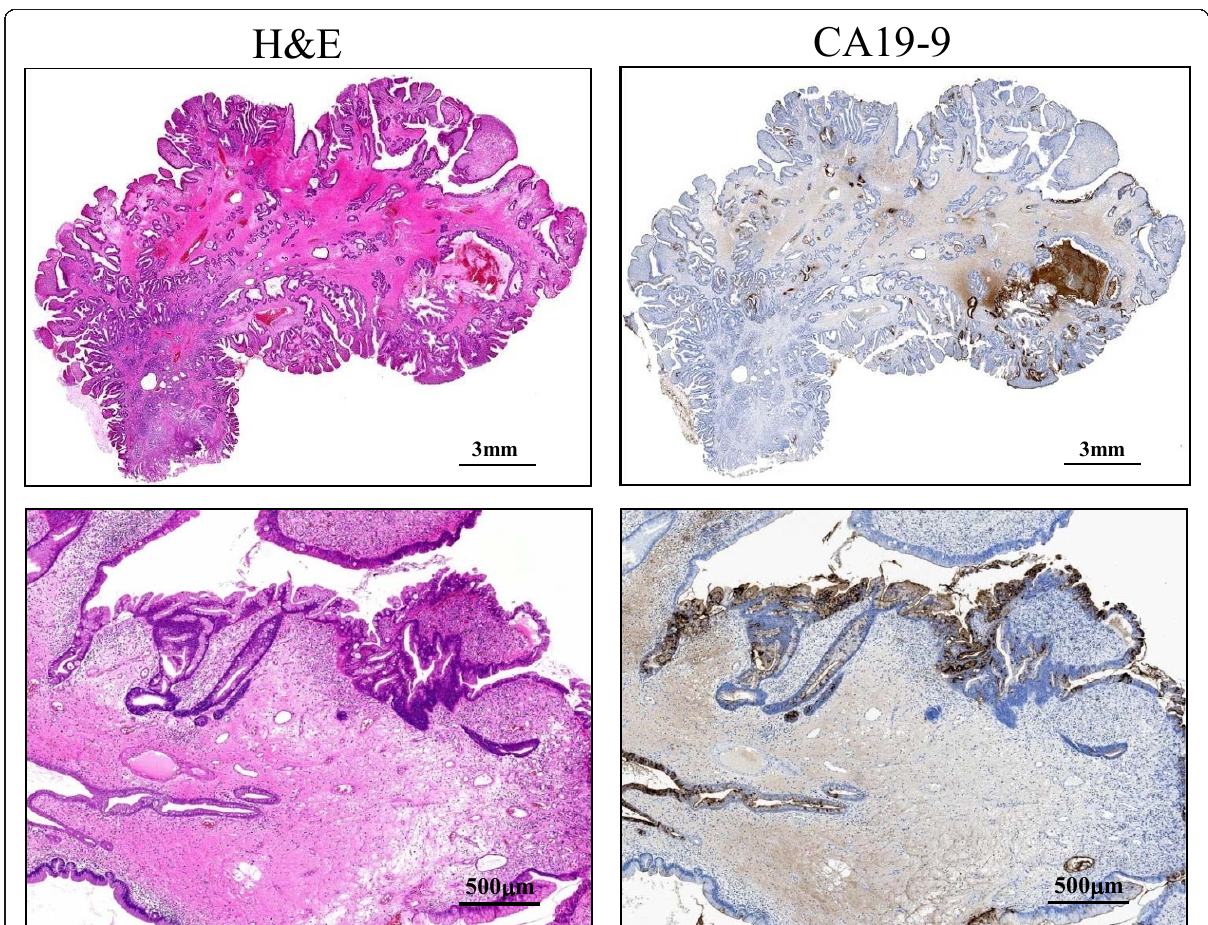
Figure 2 Scanning view and low-power image of the polyp . (H & E) The scanning view and low-power image of Hematoxylin-eosin (H & E) staining demonstrate that the lesion is covered by hyperplastic foveolar-type epithelium with focally distorted or cystically dilated change, supported by abundant edematous fibrovascular stroma without apparent invasive components (left upper), and small irregular and fused tubular areas are found in the hyperplastic polyp (left lower). (CA19-9) The scanning view and lower-power image of immunohistochemical staining of CA19-9 on its sequential section show a focal, not diffuse, positive-expression in the hyperplastic epithelium and, especially, in the irregular and fused tubular glands (right lower) and the secreted mucinous material into the dilated glands (right